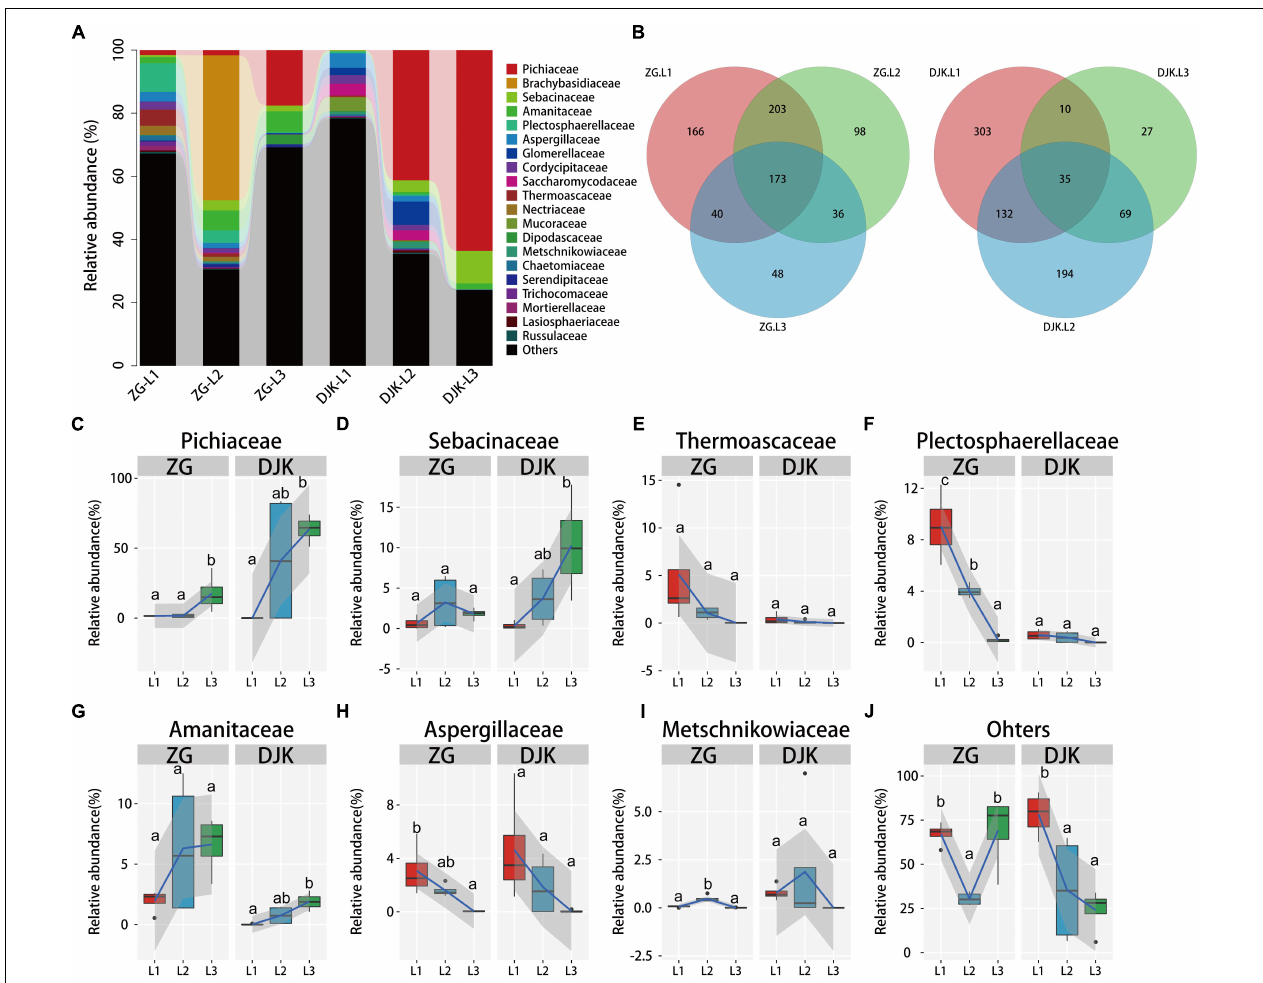
FIGURE 2 | Relative abundance of fungi across the lifespan of larvae. (A) Taxonomic breakdown at the family level grouped by different populations with different development stages. (B) Overlap of OTUs at the larval stage. (C–J) Boxplots showing the mean abundance of core fungi in the larval gut. In every panel, the left side represents the population collected from ZG ( n = 4), and the right side represents the population collected from DJK ( n = 4). The high, low, and median data values are shown in boxplots, and the lower and upper edges of every box represent the first and third quartiles, respectively. Multiple comparisons were performed in the two groups separately. Different letters indicate a significant difference between different instars in each group ( p < 0.05, one-way ANOVA, Tukey post hoc test). The lines show median values per region window, and the shaded area denotes the estimated 95% confidence